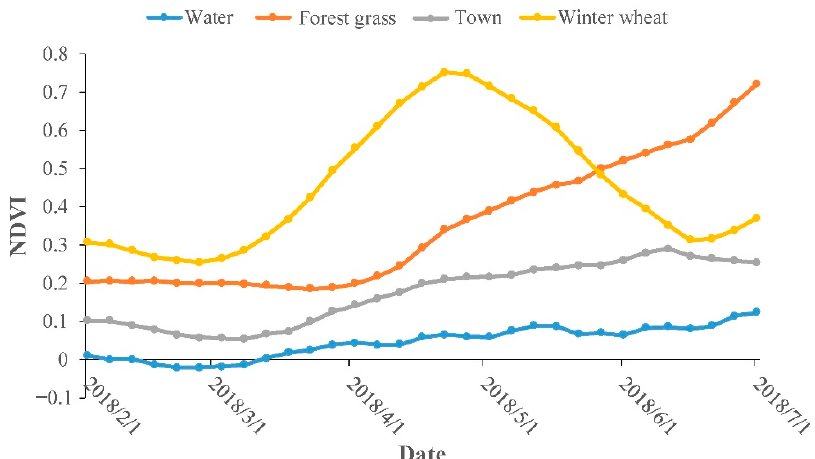
Figure 2. The Normalized Difference Vegetation Index (NDVI) time-series curves of various land cover types during the growth period of winter wheat in Hebei Province.